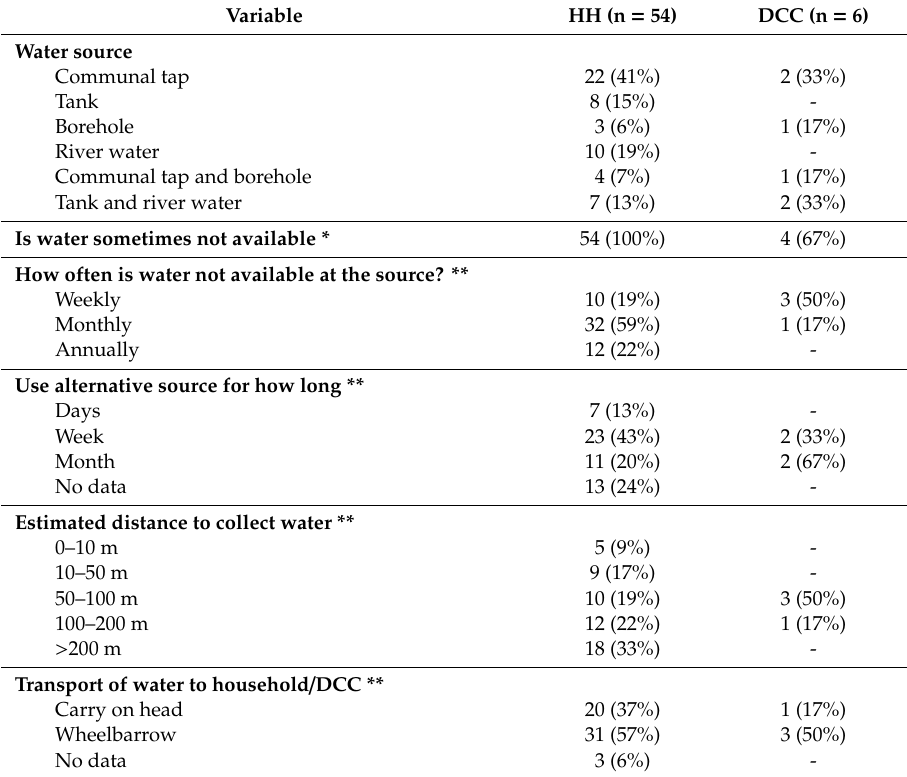
Table 3. Descriptive water demographics for the study households and DCCs.